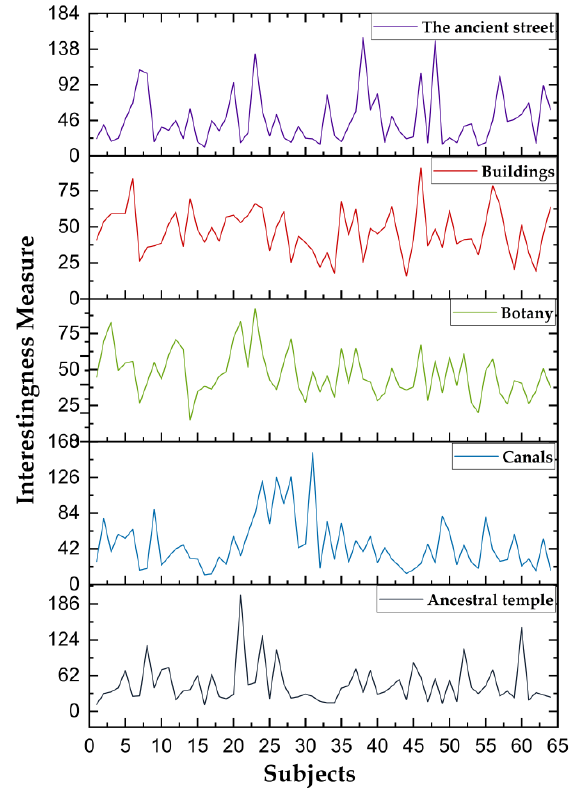
Figure 8. Trend graphs of interest level of 64 subjects in five interest areas. Source: The ErgoLAB platform was used to output the data, the X- axis represents subjects, and the Y -axis represents interest trends.